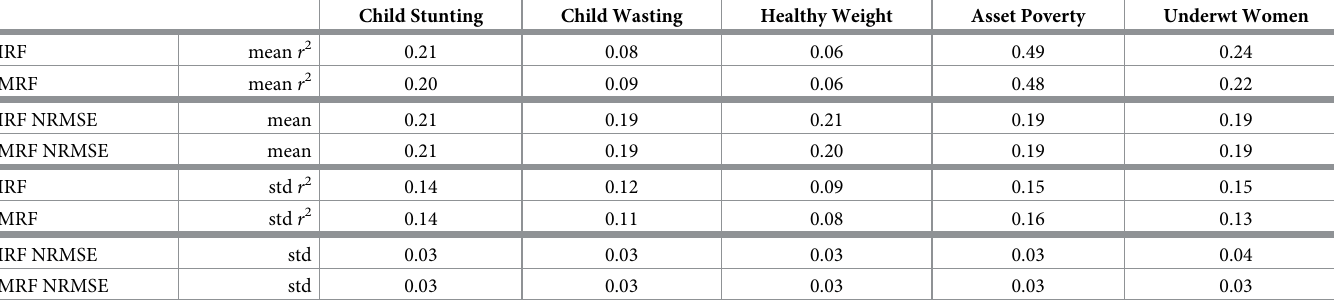
Scores are computed using predictions for all surveys within each country, with mean and standard deviation of performance measured across folds and countries. Testing and training folds are shared across